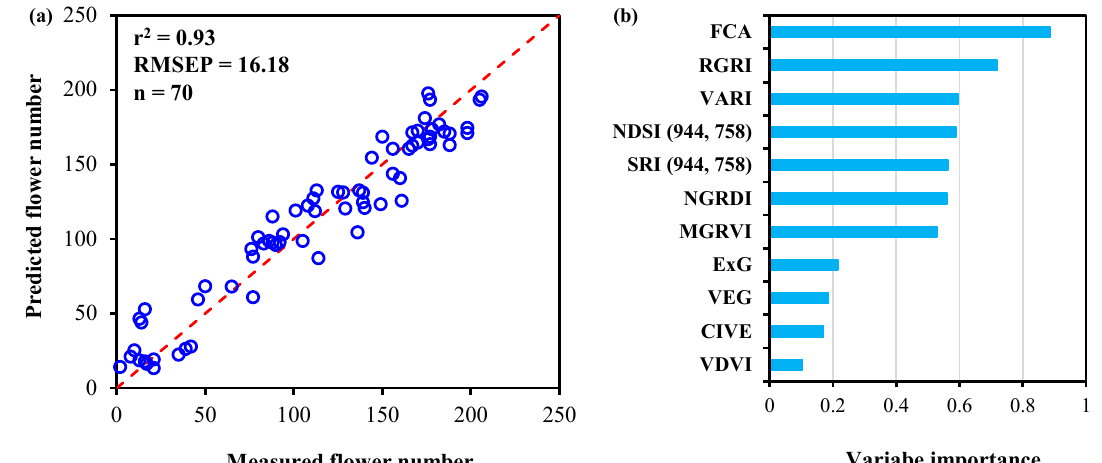
Figure 9. Estimation of flower number developed by random forest (RF) model with all UAV variables extracted from Red Green Blue (RGB) and multispectral images ( a ). Dashed red line is the 1:1 line. The right figure shows the variable importance estimation of the RF model ( b ). The r 2 and RMSEP represent the coefficient of determination and the prediction of root mean square error, respectively.